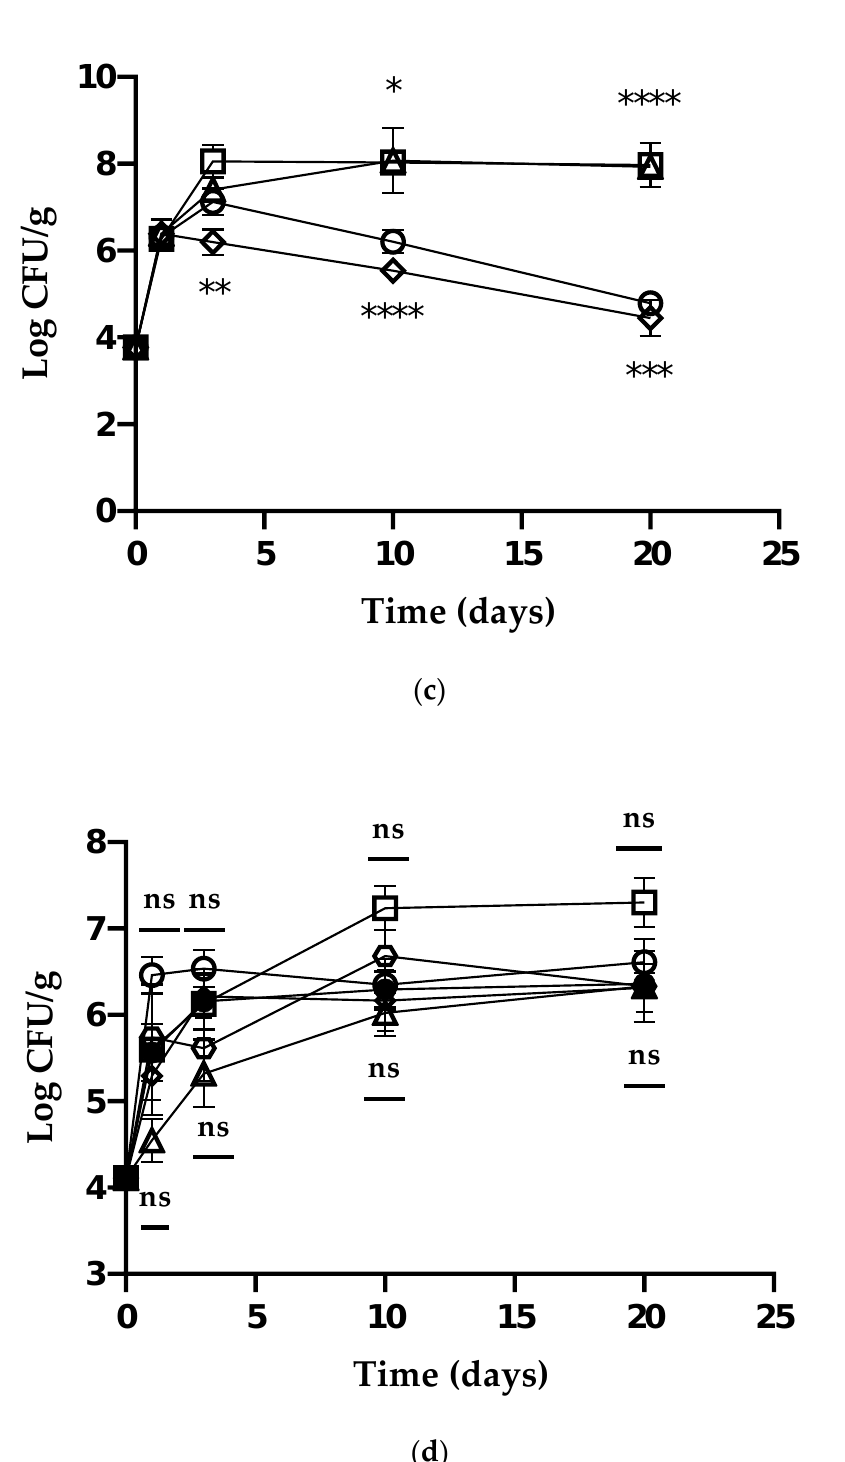
Figure 2. Listeria monocytogenes NCTC 10888 viable counts (log CFU/g) observed in the contaminated ( a ) carrots, ( b ) tomatoes, and ( c ) zucchini samples packaged in PoAF [ ○ ], PoAC [ ], PoF control [ △ ] and PoC control [ ]. Lactobacillus kefiri ( d ) viable counts (log CFU/g) observed in the contami- nated carrots, tomatoes, and zucchini samples packaged in PoAF [ ○ , △ , ], PoAC [ , , ● ]. Error bars represent standard deviations. p -values of < 0.05 (*), p < 0.01 (**), p < 0.001 (***) and p <0.0001 (****) were considered significant by t-test and ANOVA. ns stands for not statistically sig- nificant.